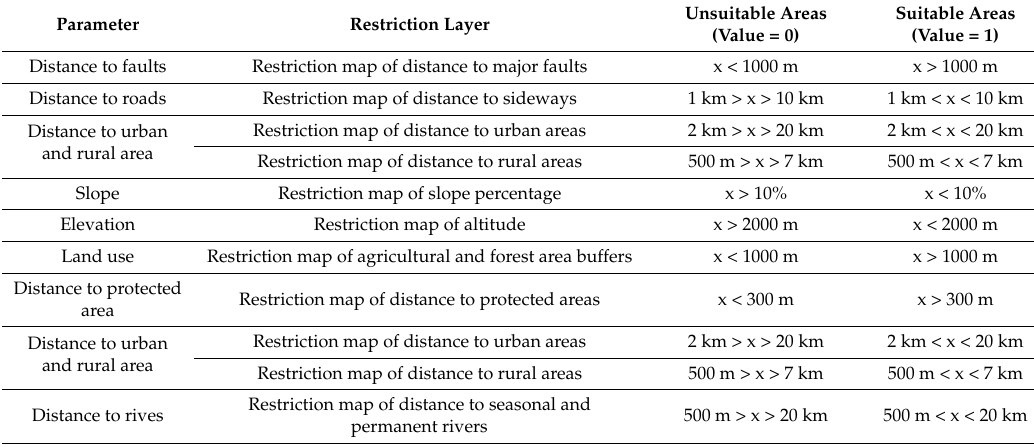
Table 1. The restriction factors for the site selection of SPPs by using Boolean Model (The suitability of